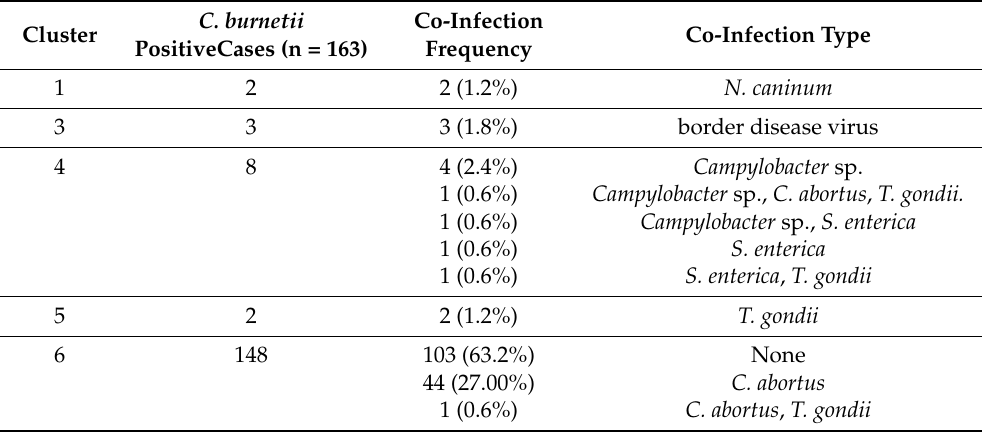
A detailed description of co-infections between C. burnetii and other pathogens in caprine abortions is shown in Table 8. In summary, co-infections with at least two pathogens were found in more than 36% cases testing positive for C. burnetii (60/163), mostly due to mixed infections with C. abortus (44/163, 27%). A total of 103 cases (63.2%) were positive for only C. burnetii . Table 8. Number of caprine abortion cases positive for C. burnetti and co-infections between C. burnetii and other pathogens in seven clusters indicated in Table 7. Data are positive count, (%).